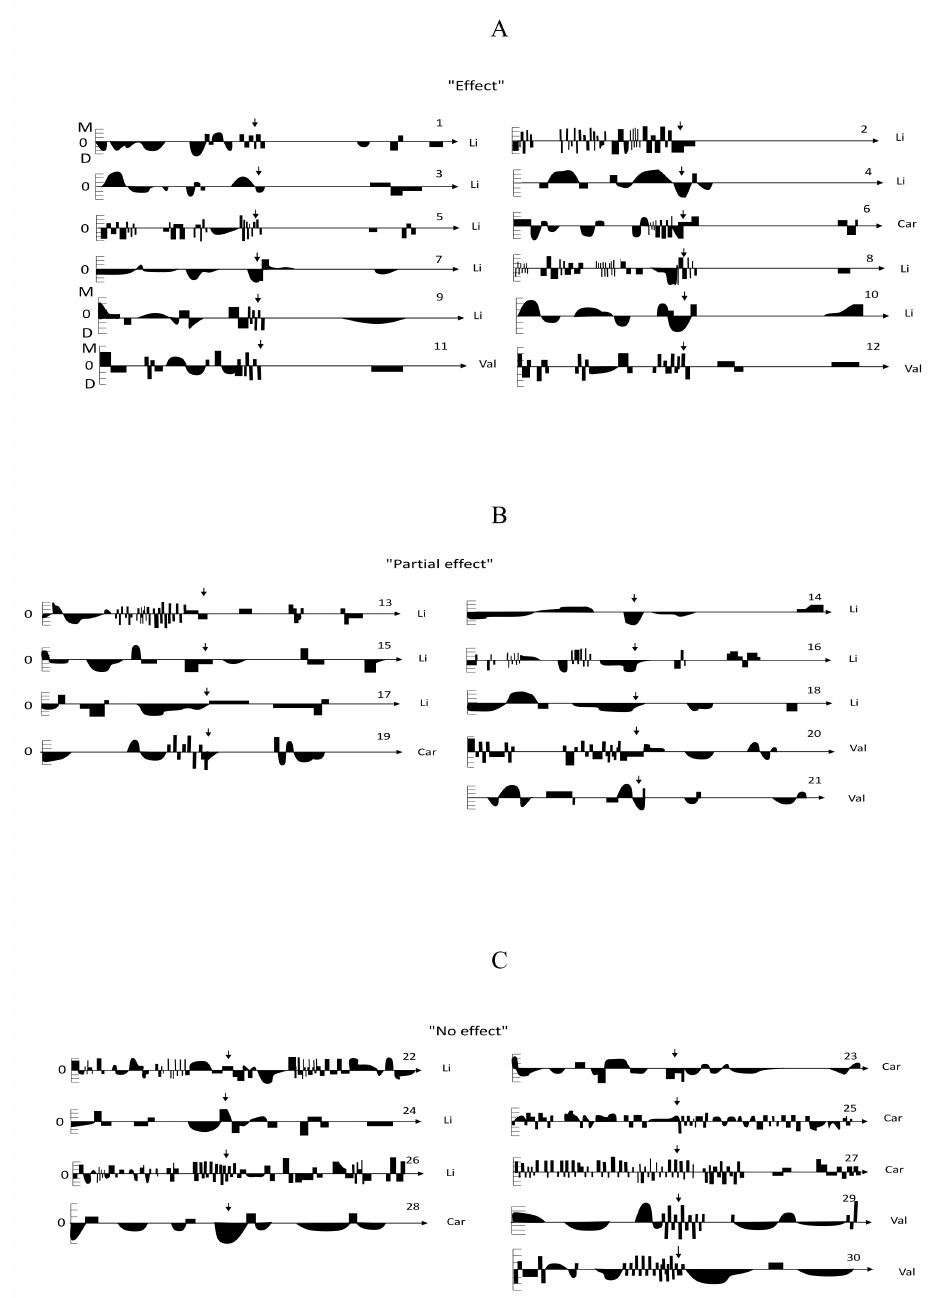
Figure 1. Individual graphic life charts of affective symptoms in the one year prior to (retrospective part) and the one year after (prospective part) the ECT course, grouped by the degree of response to the long-term mood stabilizing therapy. Footnote: Car—carbamazepine, ECT—electroconvulsive therapy, Li—lithium, Val—valproate. Axis X—severity: above 0—mania (mild, moderate, severe), be- low 0—depression (mild, moderate, severe). Axis Y—the duration of affective symptoms—12 months before and 12 months after the ECT, whose beginning is marked with an arrow. ( A ) Patients #1–12— very good response with the achievement of remission (“Effect” or very much improved as measured with the CGI-BP). ( B ) Patients #13–21—good response (“Partial effect” or much improved in the CGI-BP). ( C ) Patients #22–30—no response to long-term mood stabilizing therapy (“No